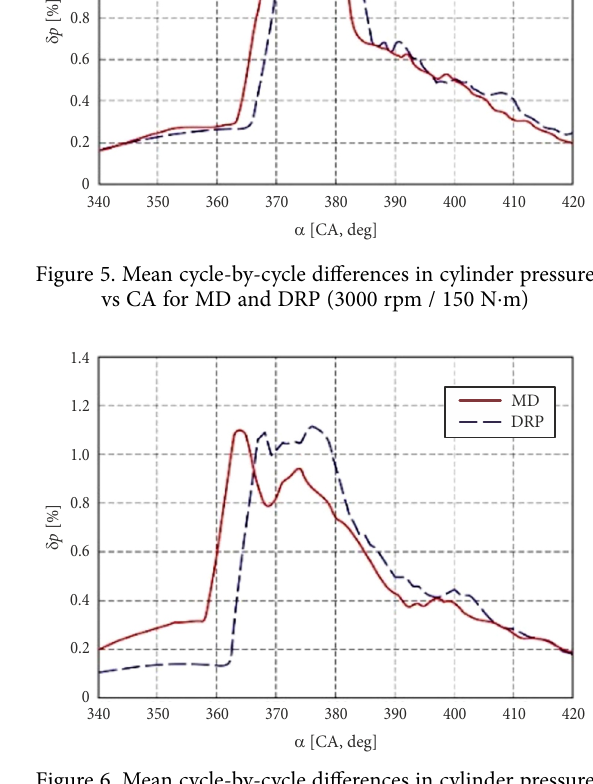
Figure 3. Mean cycle-by-cycle differences in cylinder pressure vs CA for MD and DRP (1500 rpm / 200 N ⋅ m)